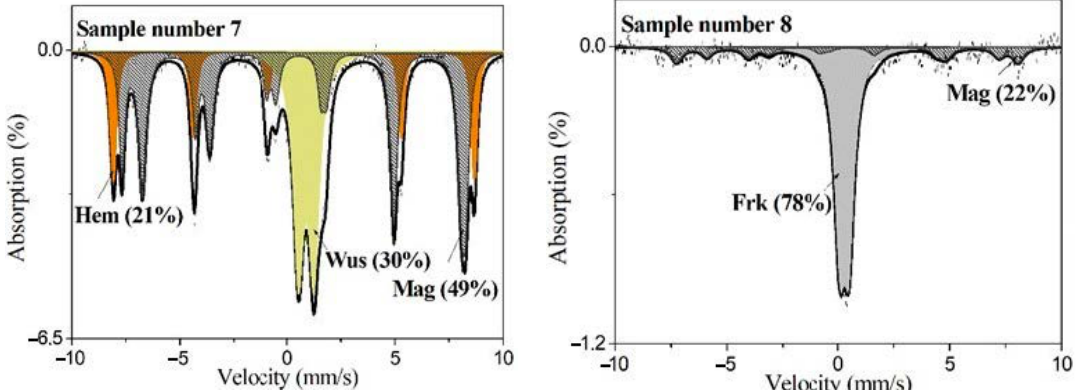
Figure 13. Mössbauer spectra obtained for scale (No. 7) and dedusting dust (No. 8). Fitted subspectra, their assignments and contribution are visible on the spectra; Hem—hematite, Mag—magnetite, Wus—wüstite, Frk—franklinite. Absolute errors are estimated at ± 1% for components areas.